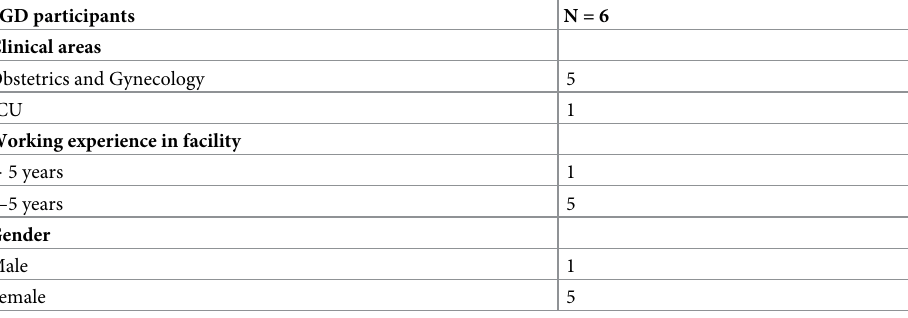
Table 3. Focus group discussion with registered